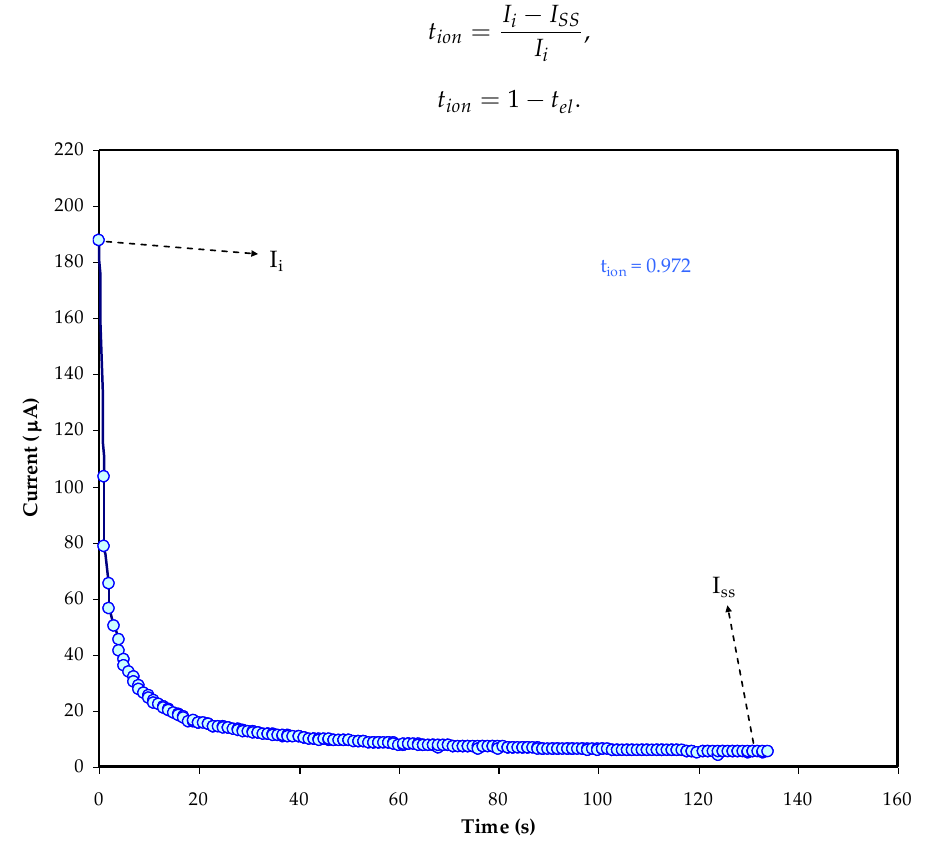
Figure 2. The trend of current over time throughout polarization for the MC:DN:NH 4 SCN:Gly:Zn electrolytes.